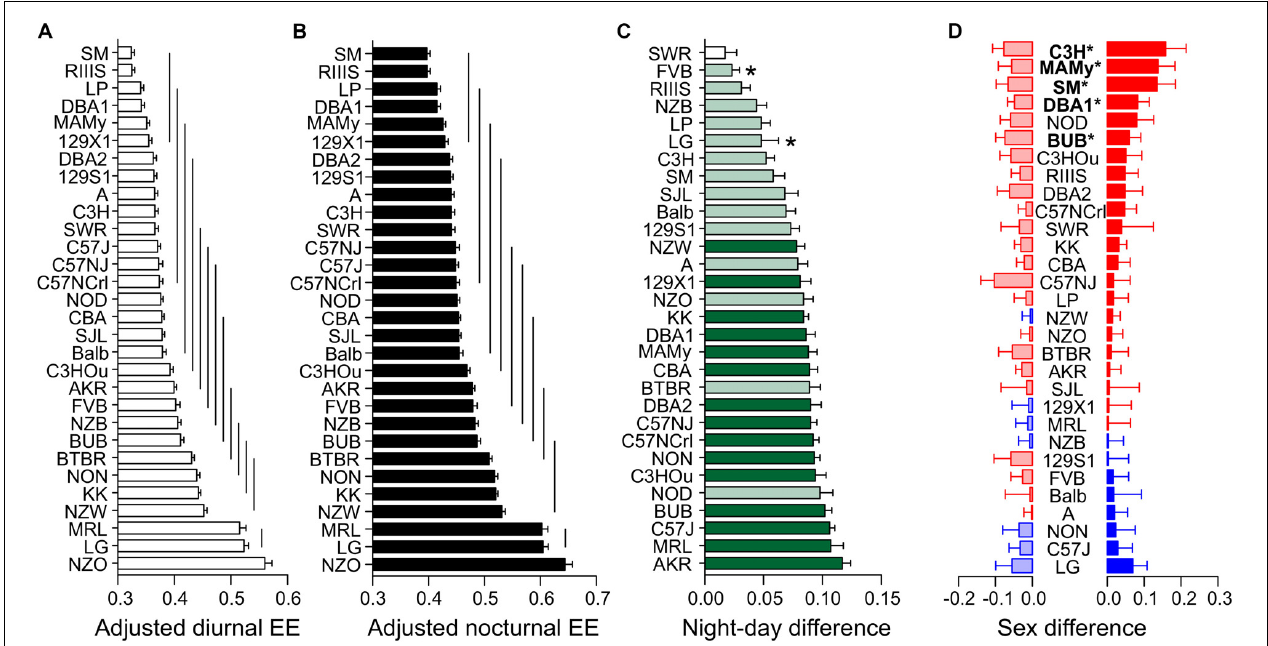
FIGURE 7 | Strain, day–night, and sex differences in energy expenditure. EE was measured as kcal/h and adjusted for body mass and age differences by ANCOVA. (A,B) ANCOVA-predicted values of EE illustrate the differences of diurnal (A) and nocturnal EE (B) between the inbred strains. The values are given as mean values averaged from collapsed sexes. Error bars represent standard errors of the mean and the vertical lines connect groups with homogenous means according to Tukey’s post hoc test. (C) Day–night differences were ranked and Cohen’s D calculated. Significant differences at p < 0.004 are indicated with asterisk and p -levels < 0.001 were not marked; “n.s.” not significant. The effect sizes ranged from D = 0.62 (LG) to D = 4.97 (C57J) and are indicated in light green ( D = 0.62 and D < 2) and dark green ( D ≥ 2). (D) Sex differences were apparent in five strains at p < 0.02. The strains are ranked from largest to smallest sex difference for the scotophase, beginning, at the top, with strains, where females (red) had higher EE than males, while blue columns illustrate the opposite. To the left, nocturnal values are associated with the respective diurnal values and are displayed in light colors. All values are displayed as means ± standard error of the difference. Asterisks and bold font indicate significant sex differences, * p <